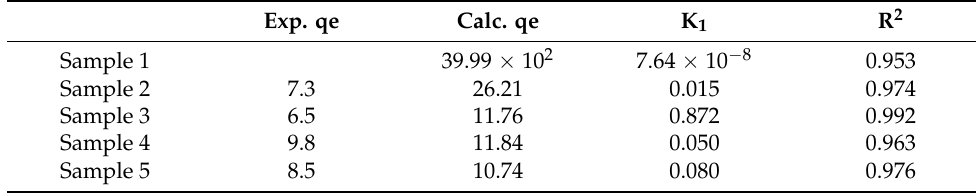
Figure 6. Nonlinear fit of pseudo-first order and pseudo-second order for phenol adsorption of sample 3 at a 75 mg/L of concentration and 100 mg sorbent. Table 1. Pseudo-first order parameters .